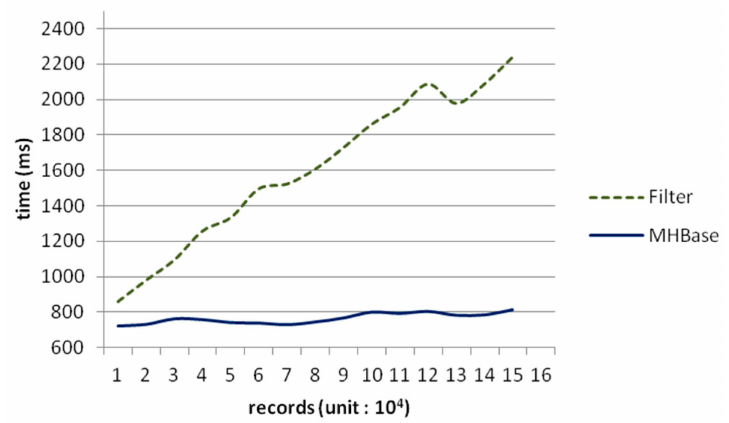
Figure 8. Performance in different data size.